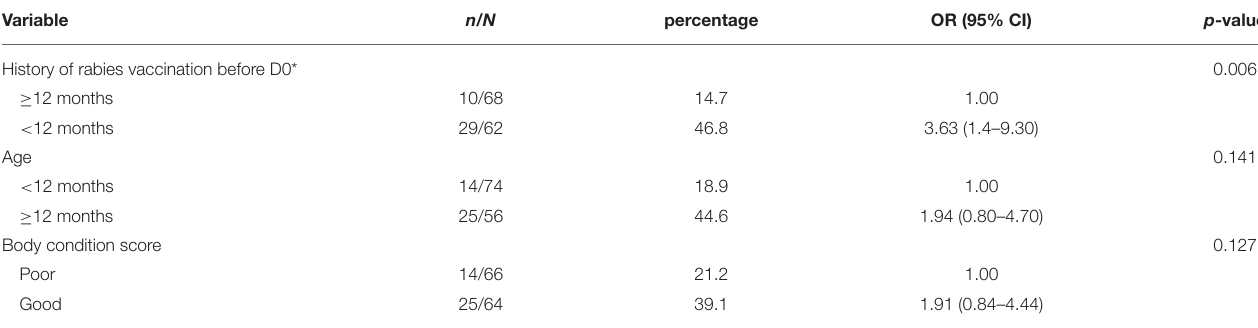
TABLE 3 | Determinants associated with developing of adequate level of binding antibodies at D0 in dogs on Flores Island, Indonesia, using multivariable logistic regression analysis. Variable n /